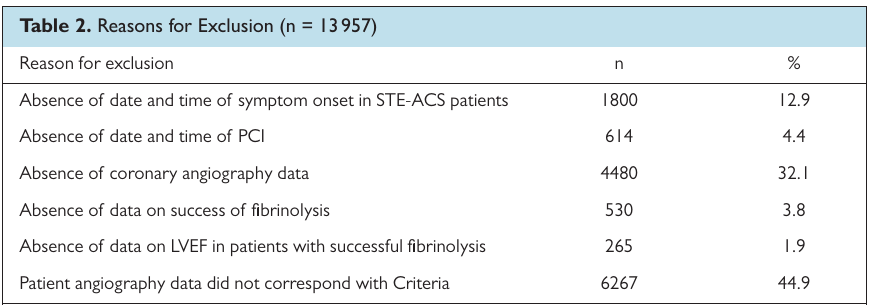
Table 2. Reasons for Exclusion (n = 13 957) Reason for exclusion n Absence of date and time of symptom onset in STE-ACS